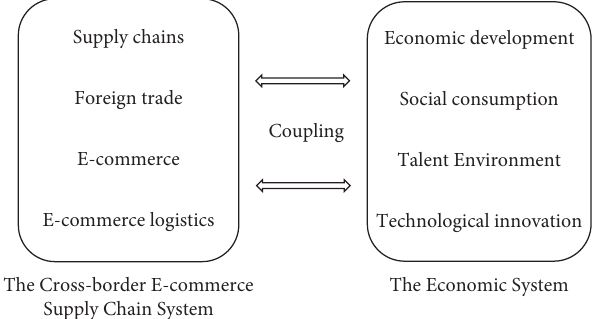
Figure 1: Coupling model between CBECSC system and economic